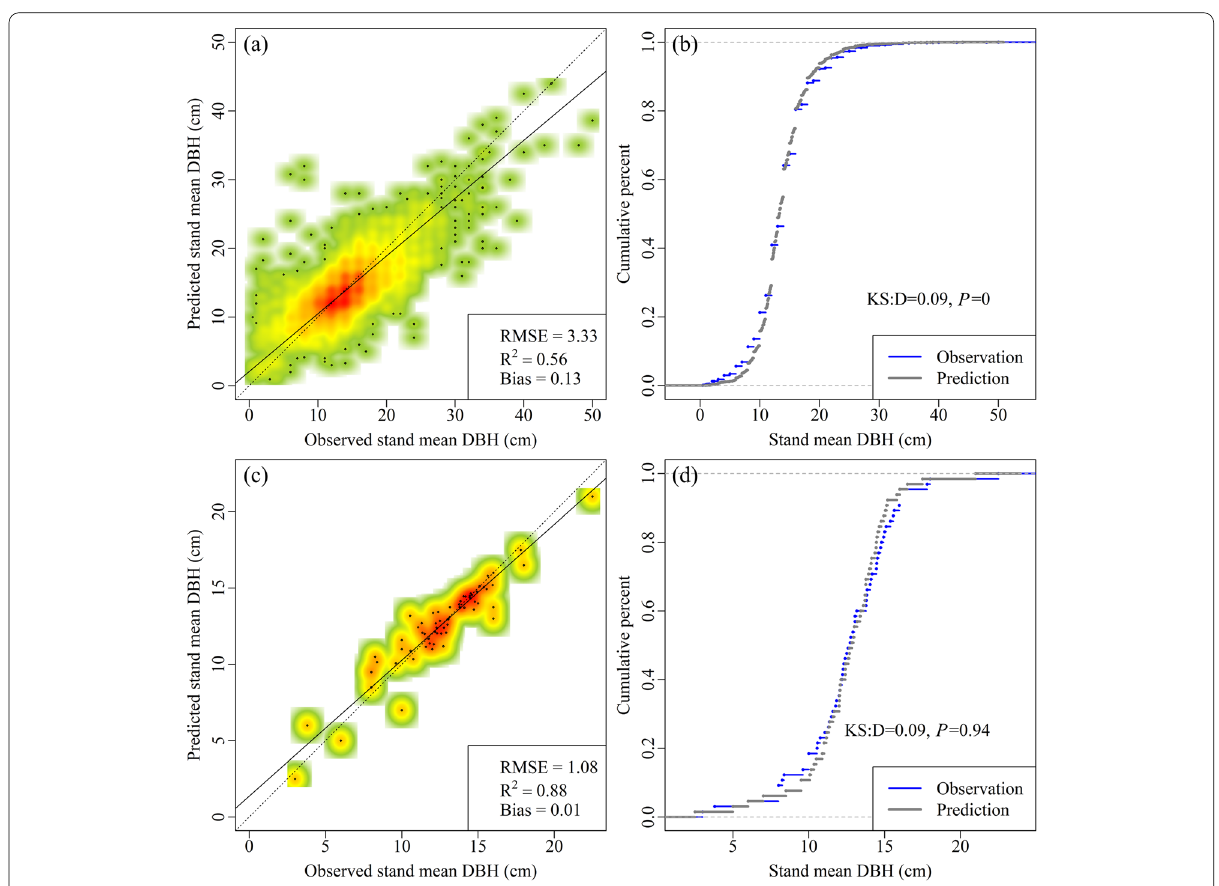
Fig. 4 a Density scatterplot between the observed and predicted stand mean DBH at the stand scale, b cumulative distribution functions of the observed and predicted stand mean DBH at the stand scale, c density scatterplot between the observed and predicted stand mean DBH at the ecotype scale, and d cumulative distribution functions of the observed and predicted stand mean DBH at the ecotype scale. The dotted line in a and c is the 1:1 line and the solid line in a and c is the regression line of geometric mean